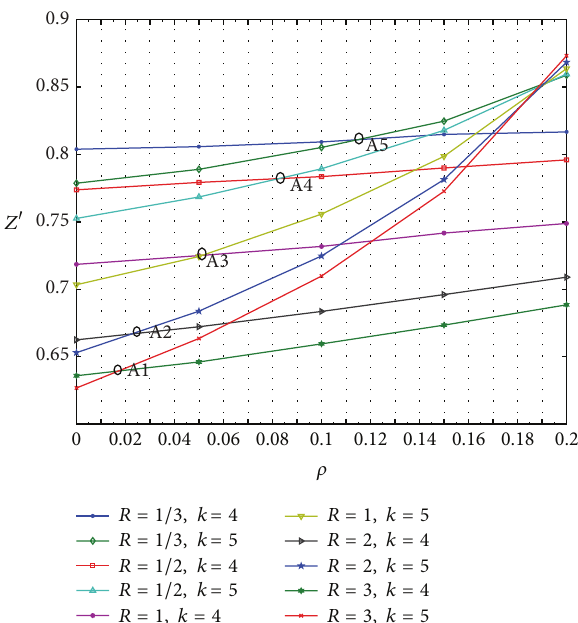
Figure 14: Effect of 𝜌 on the scheduling results when 𝑅 assumes different values.